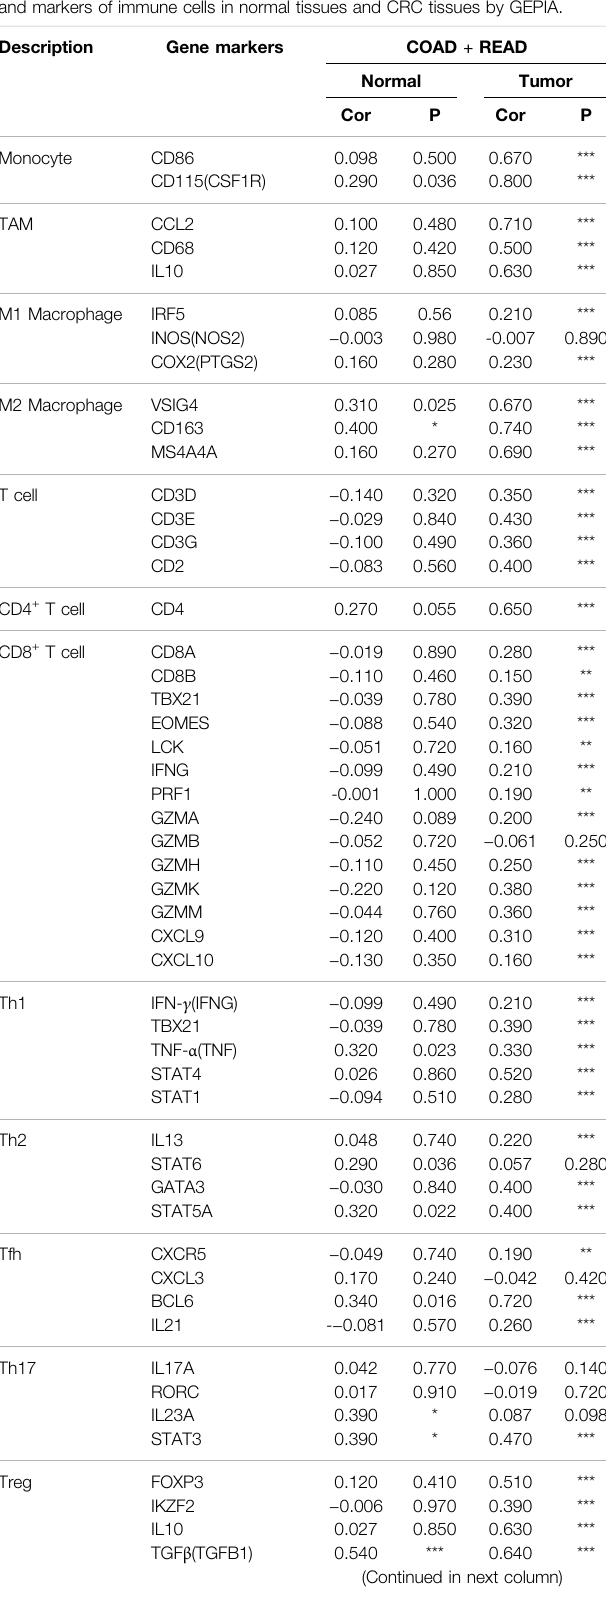
TABLE 2 | ( Continued ) Correlation analysis between SEMA6B expression and related genesand markers ofimmune cellsin normal tissuesand CRC tissues by